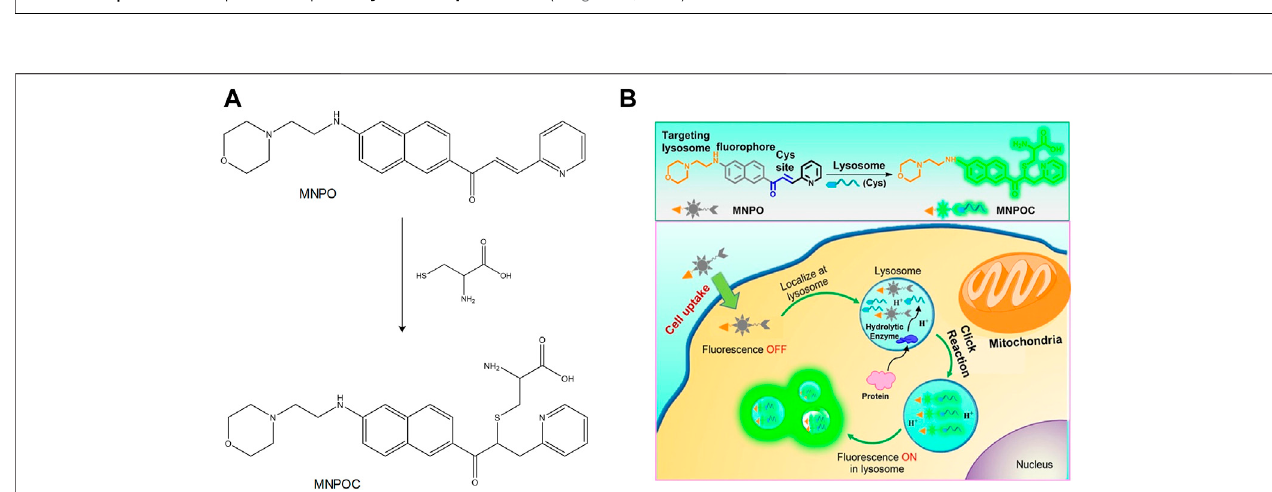
FIGURE 9 | The reaction process of probe LysoNO-Naph with NO (Feng et al., 2016).